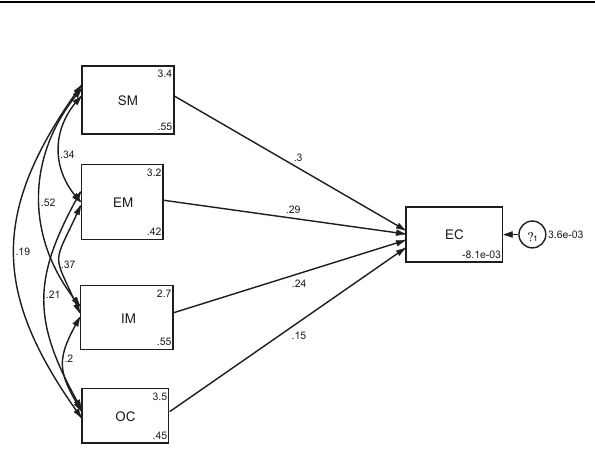
Fig. 2 Path diagram (motivators of employee commitment). Source: Author ’ s computation